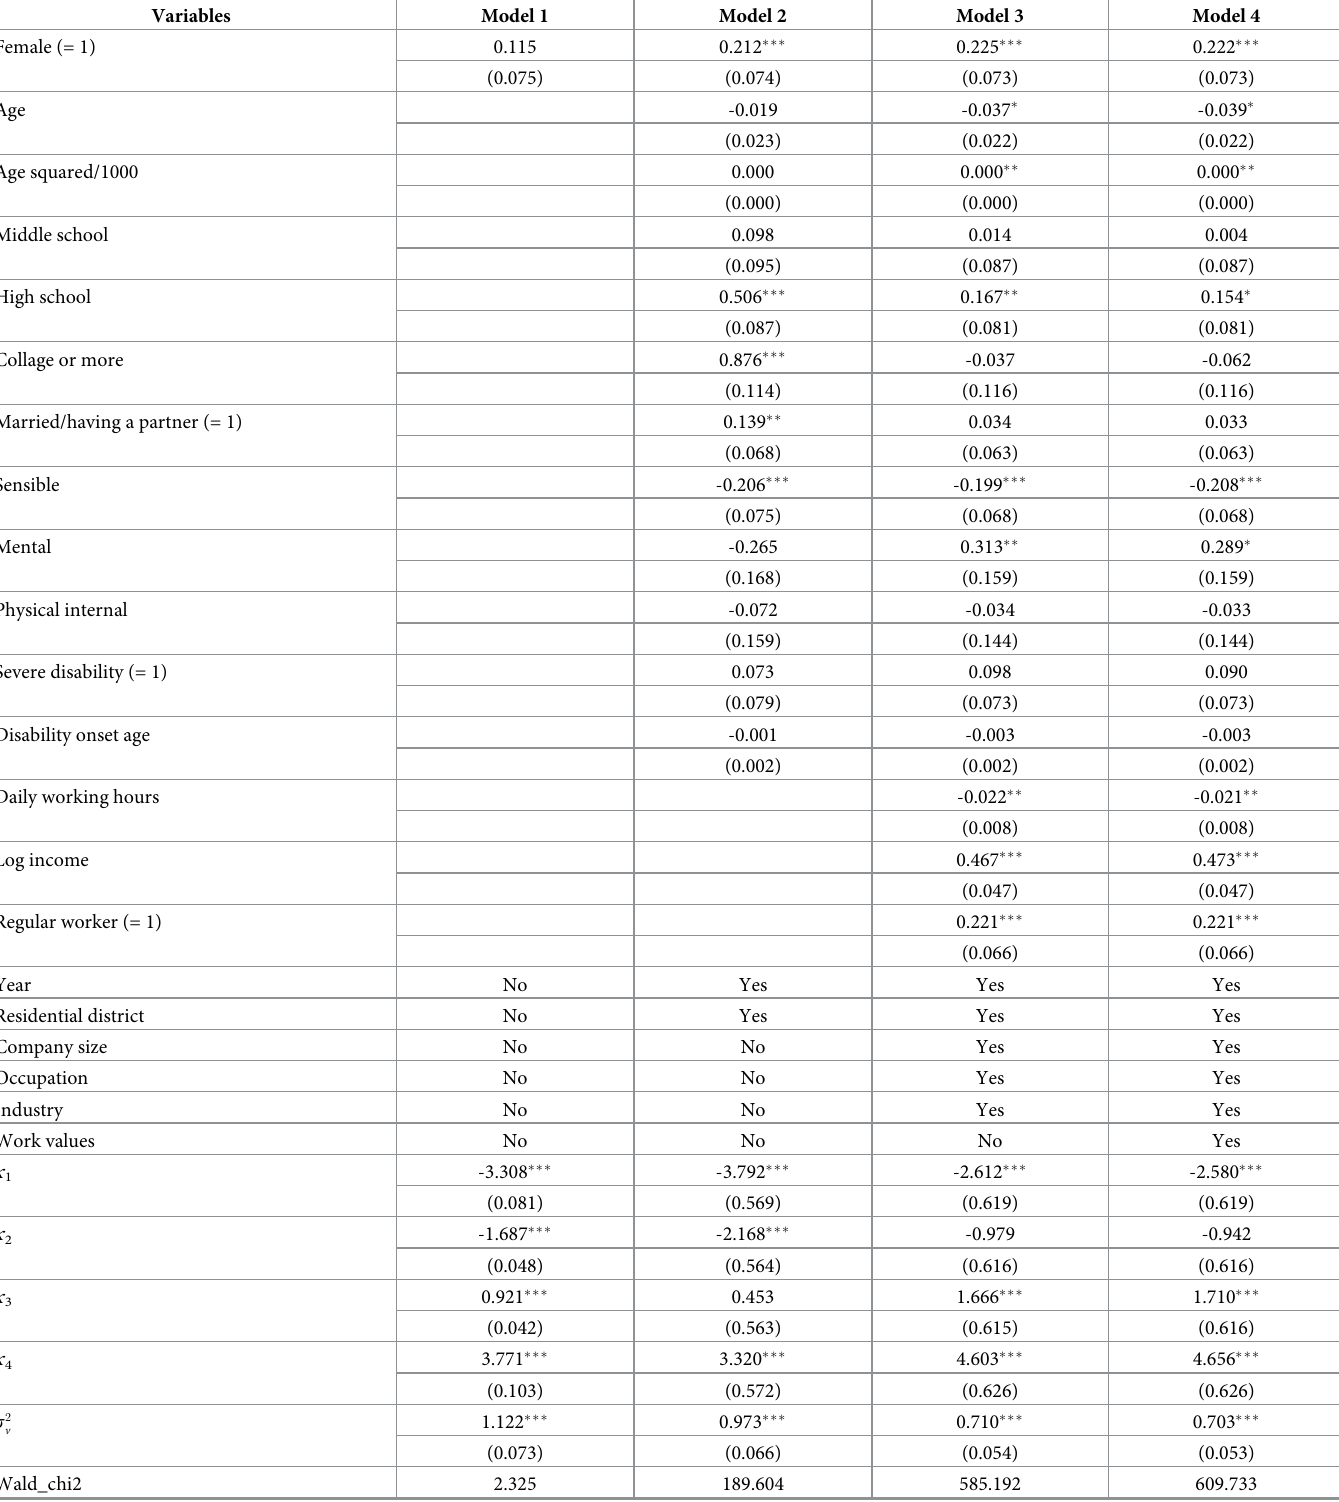
Table 3. Coefficient estimates of job satisfaction